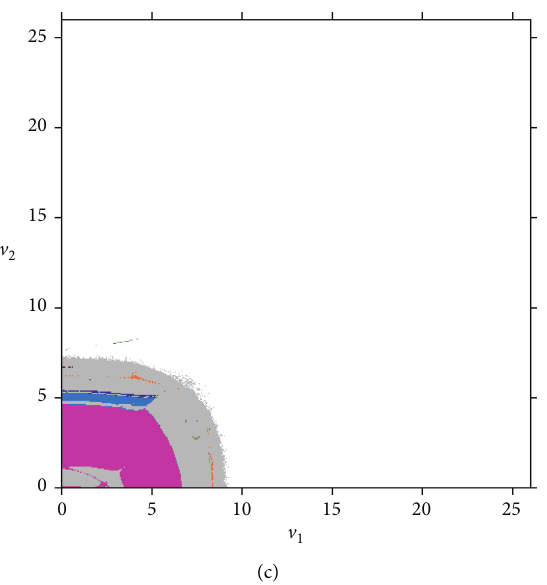
Figure 6: The 2D bifurcation diagrams in the ( v � 0 . 01 and δ (b) δ 1